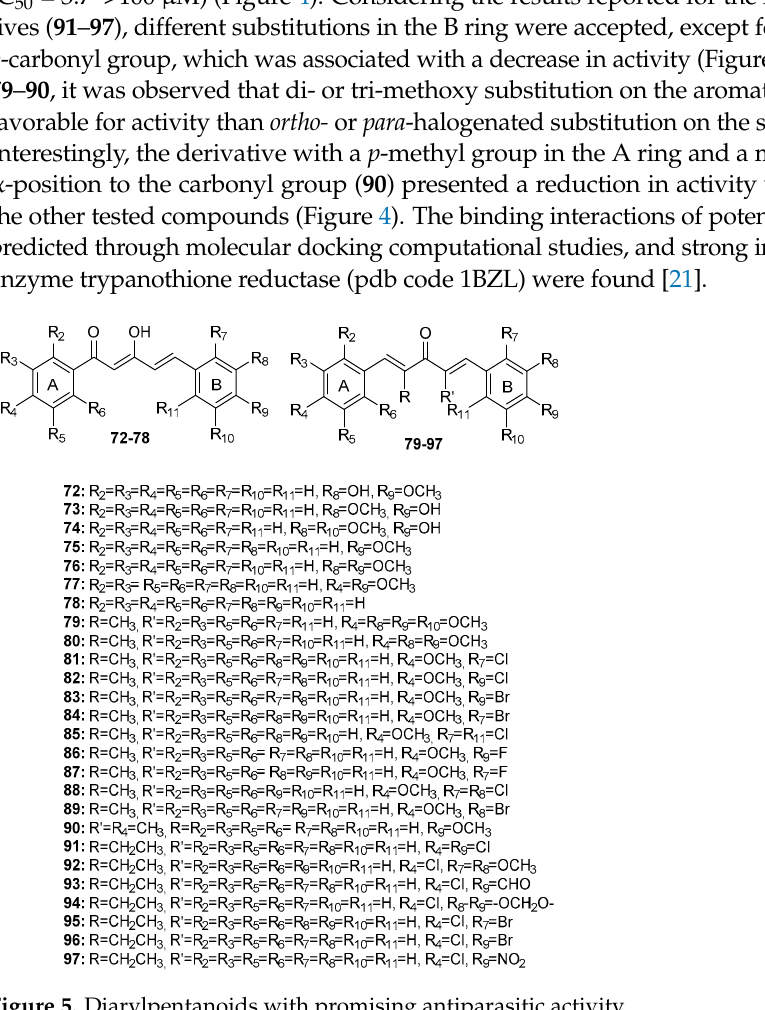
Figure 5. Diarylpentanoids with promising antiparasitic activity.